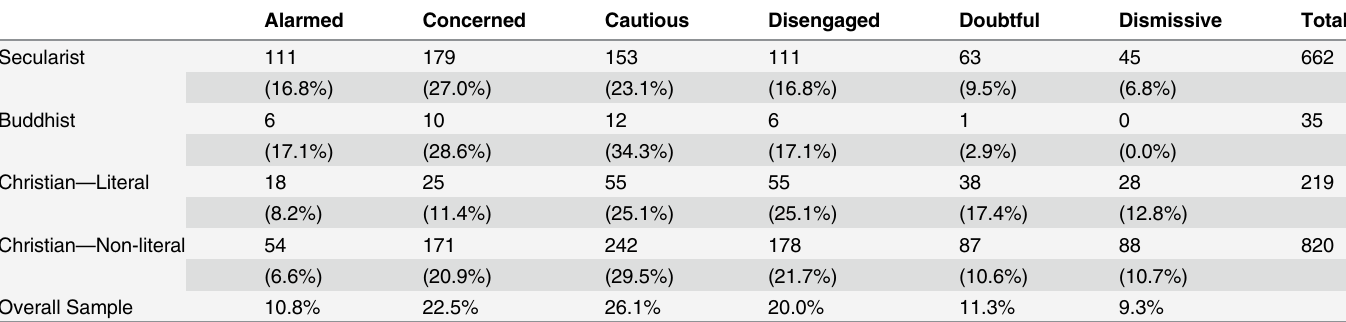
Table 2. Segment membership and religious affiliation.